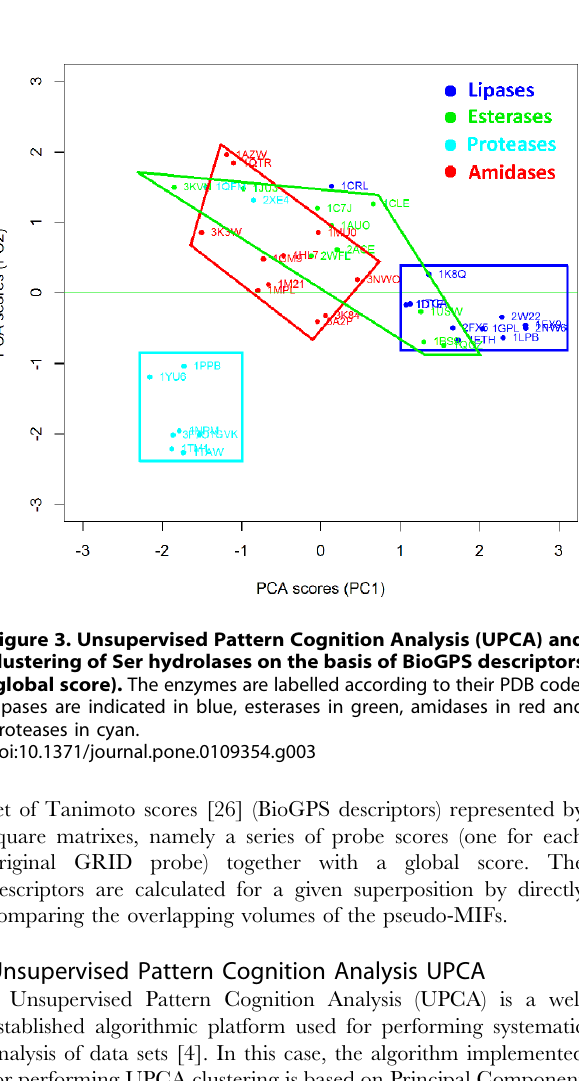
Table 2. CaLB mutants used for the validation of the BioGPS-UPCA model and taken from ref 20 and ref 39.